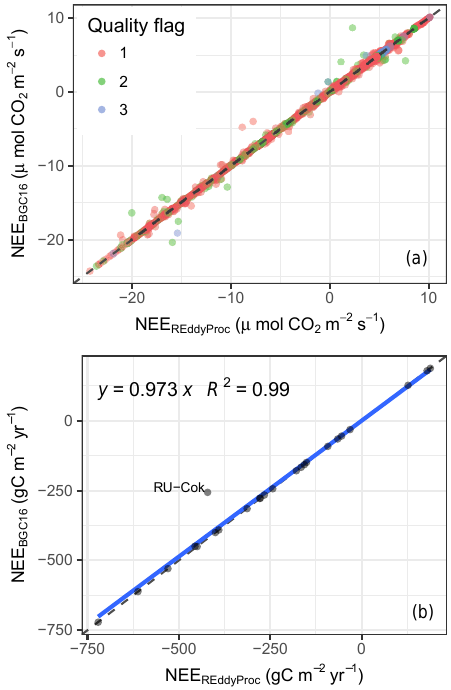
Figure 5. Predictions of NEE by REddyProc after gap filling agree with BGC16 both at half-hourly values (a) , shown for the DE-Tha 1998 case, and annual means across sites (b) . Larger qual- ity flags are associated with larger window